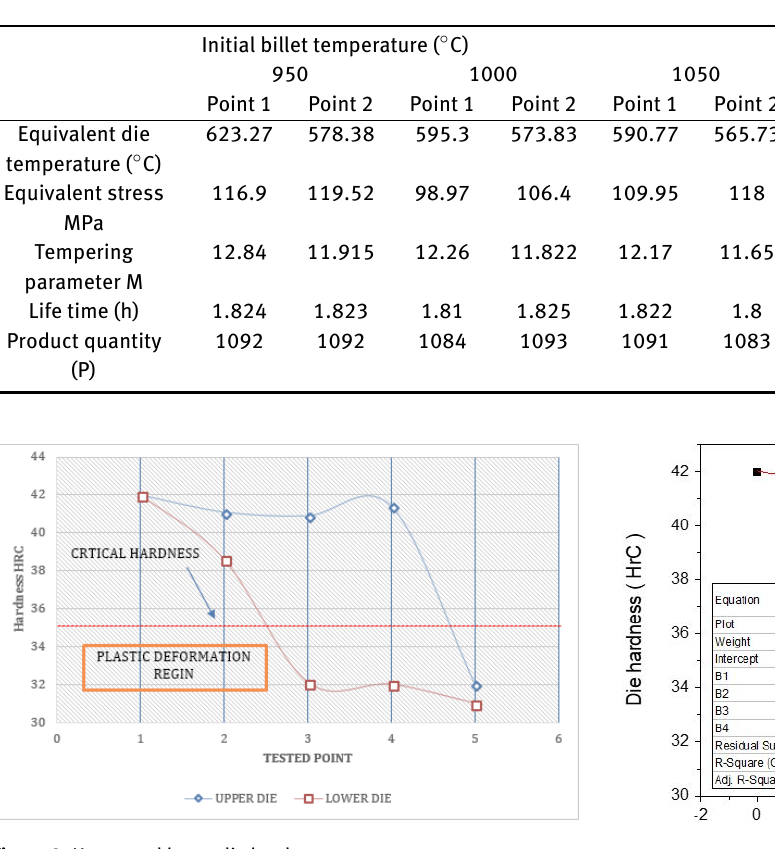
Table 3: Upper die service life in terms of plastic deformation